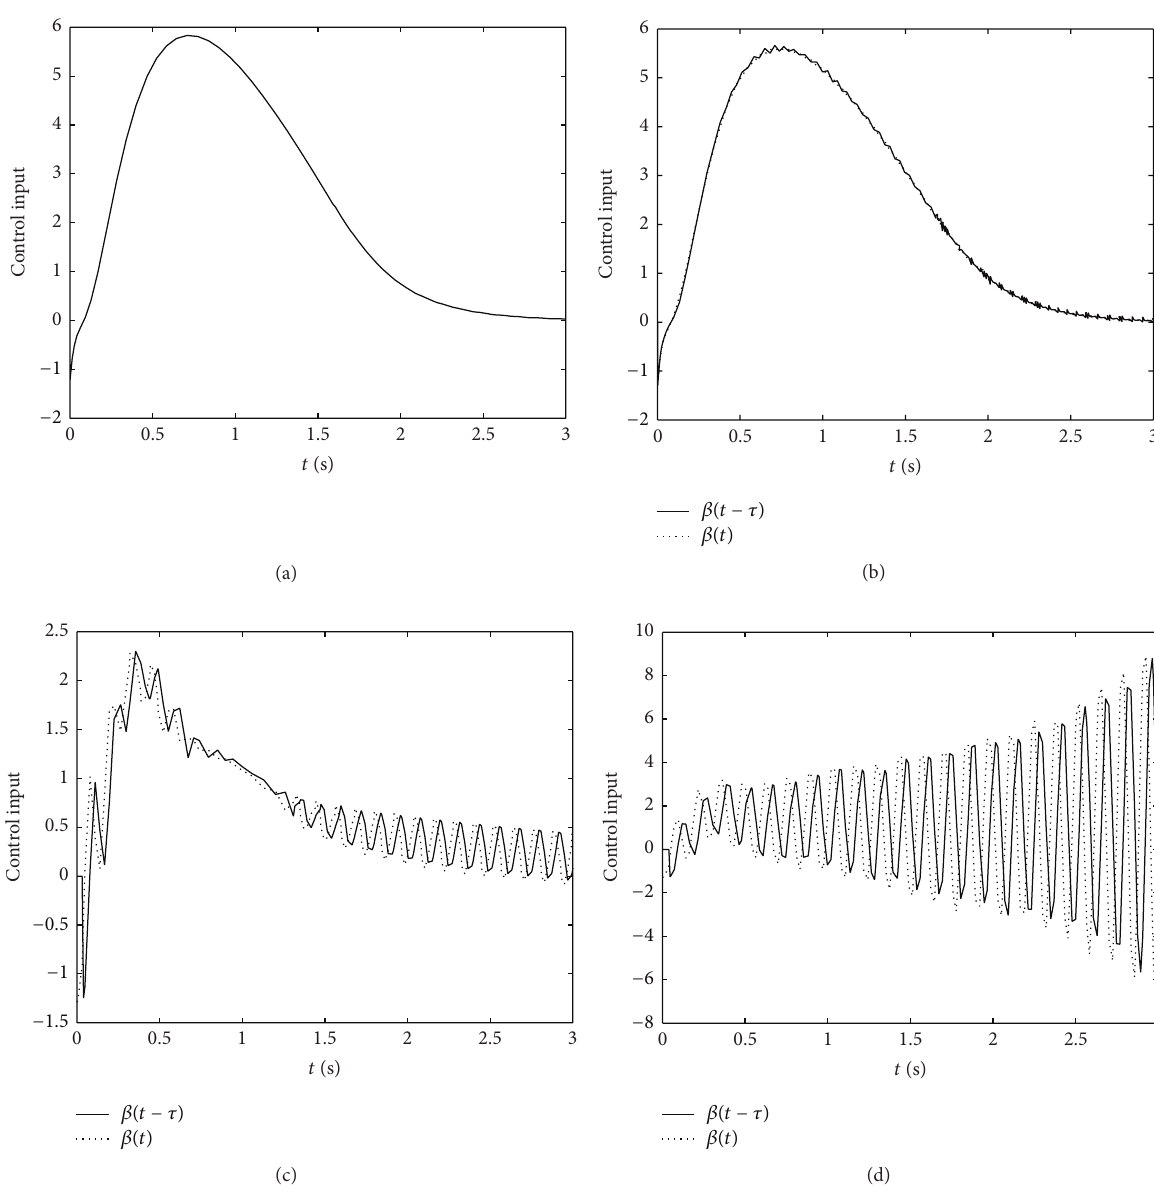
increasing, a high-frequency vibration of small